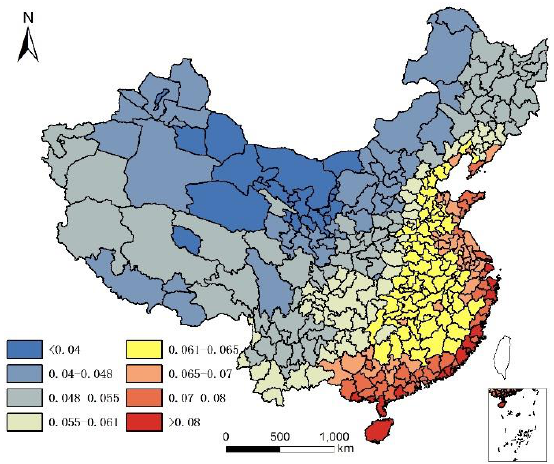
Figure 14. Simulated Longevity rate (85+/65+) in China with altitude, per capita sea fish consumption and humidity in 2010.